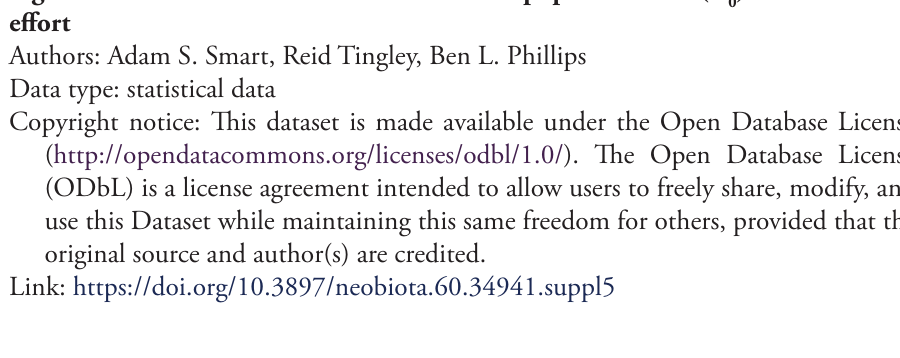
Figure S4. Posterior distributions of cane toad population size ( N